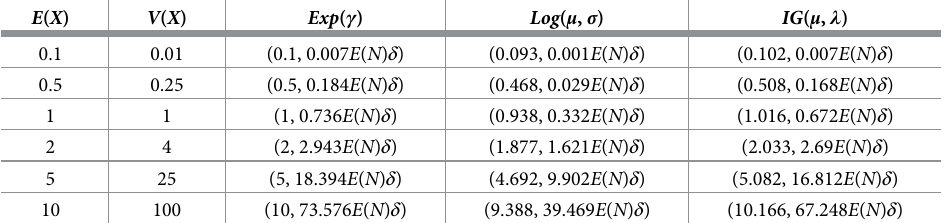
Table 3. Optimal value of a and difference ( a � , dif ( a � )) for Exp ( γ ), Log ( μ , σ ) and IG ( μ , λ ) claim amount distributions. E ( X ) V ( X ) Exp ( γ )